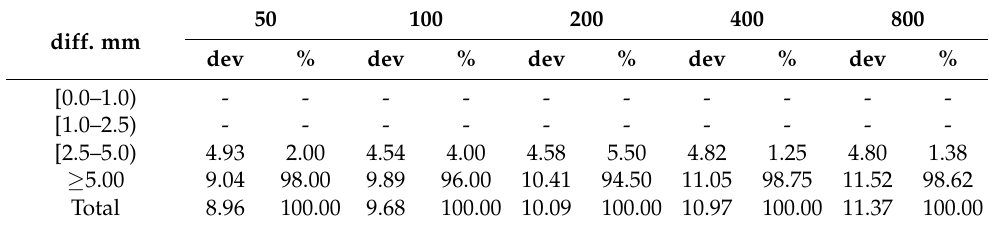
800 semilandmarks, which are 4.87% and 7.62% of the average distance (computed